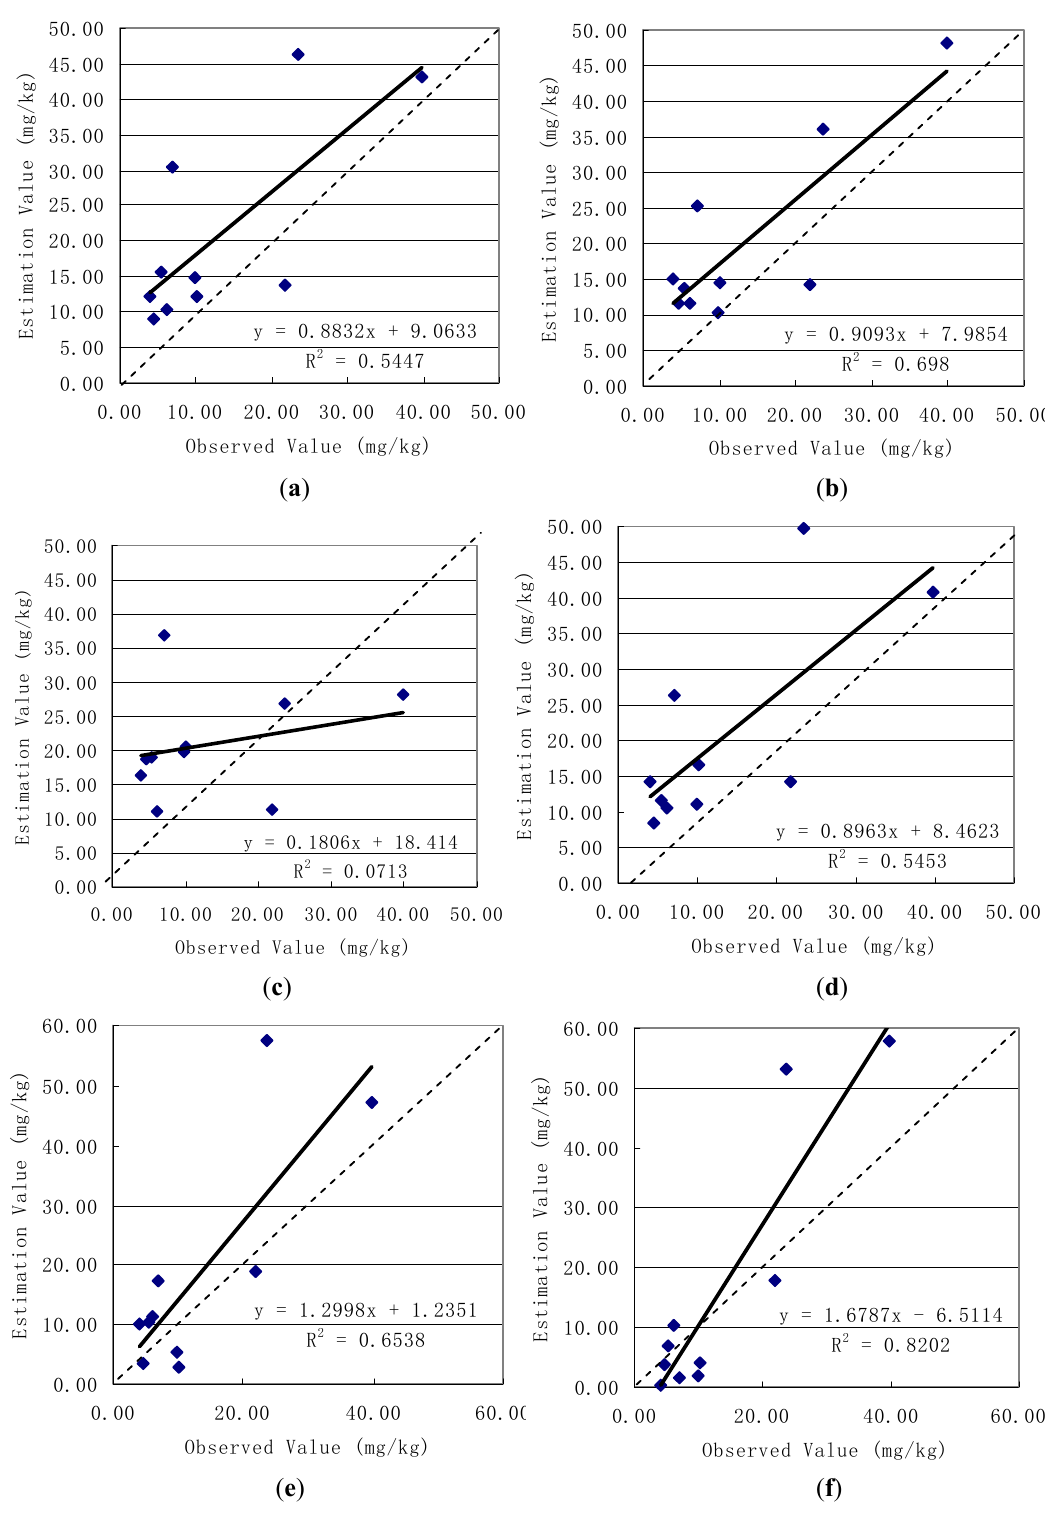
y = 0.8832x + 9.0633